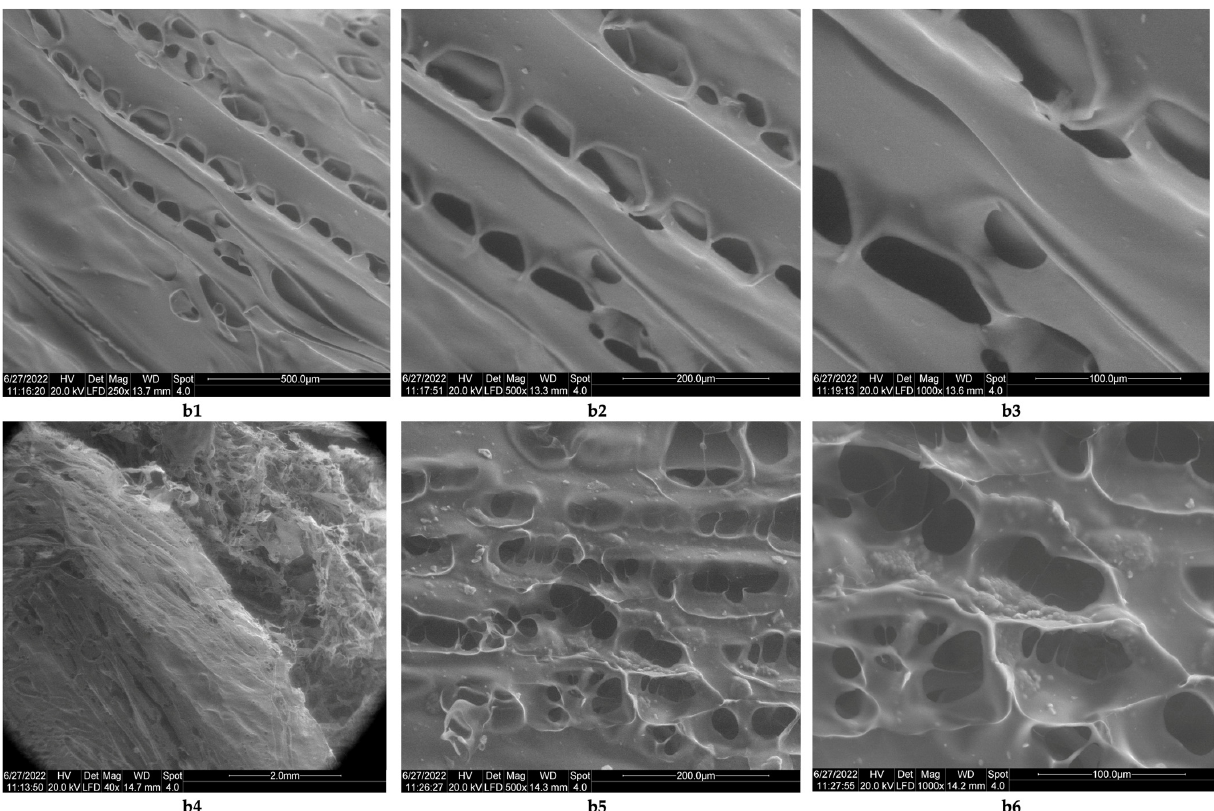
Figure 6. Morphology of chitosan sponge obtained by lyophilization: ( b1 ) lamellar structure of chitosan sponge (magnification 250 × ); ( b2 ) lamellas from a sponge of chitosan; distance between lamellas under 200 µ m (magnification 500 × ); ( b3 ) details regarding pores from the lamellar structure, with dimensions under 100 µ m (magnification 1000 × ); ( b4 ) interconnected pore distribution inside of sponge of chitosan (magnification 40 × ); ( b5 ) pore geometry inside of chitosan sponge (magnification 500 × ); ( b6 ) pore geometry from sponge of chitosan with inhomogeneities present in its internal structure (magnification 1000 × ).